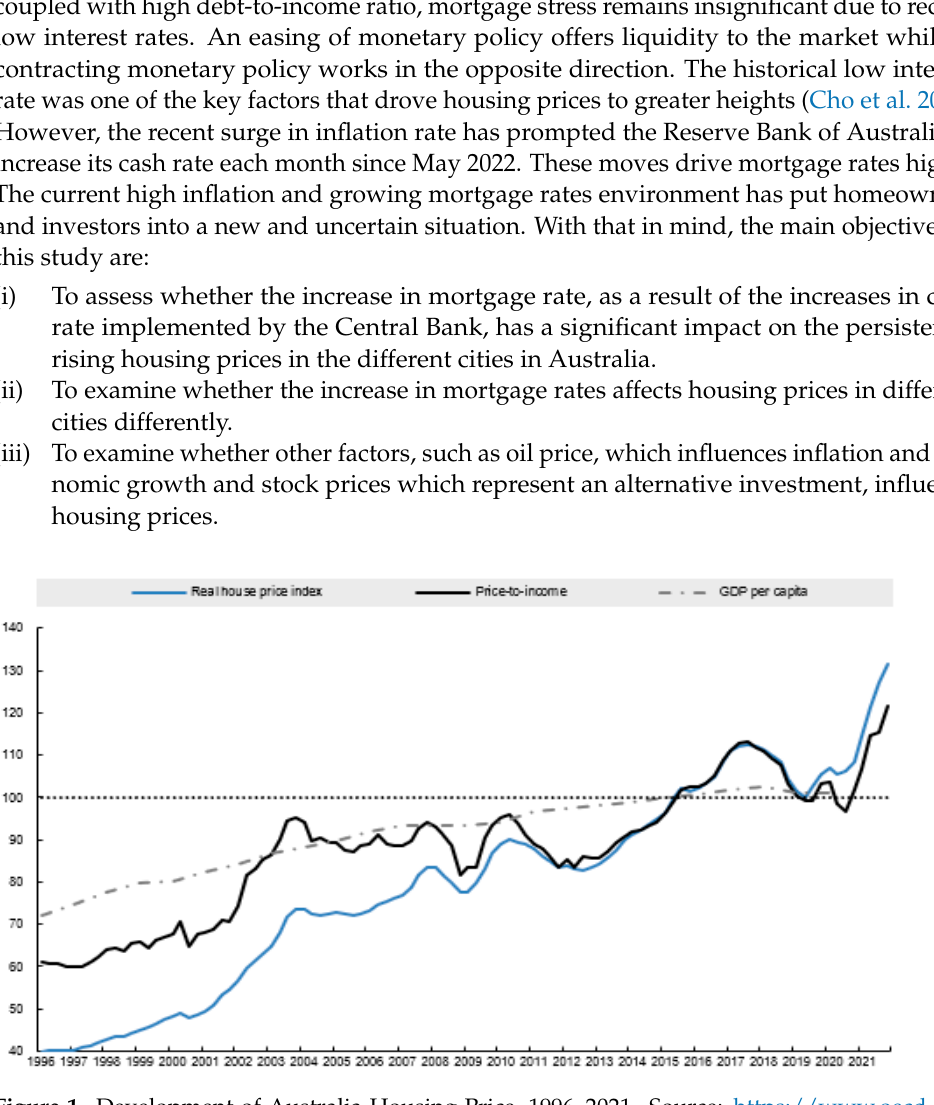
Figure 1. Development of Australia Housing Price, 1996–2021.